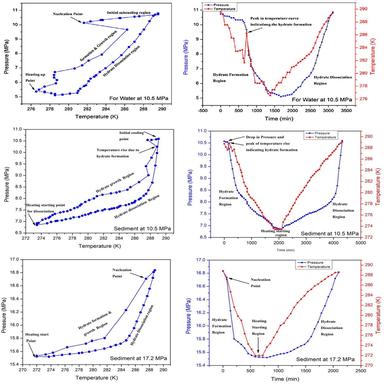
(a) Hydrate formation and dissociation curves (b) P-t-T diagrams of hydrates at 10.5 and 17.2 MPa.